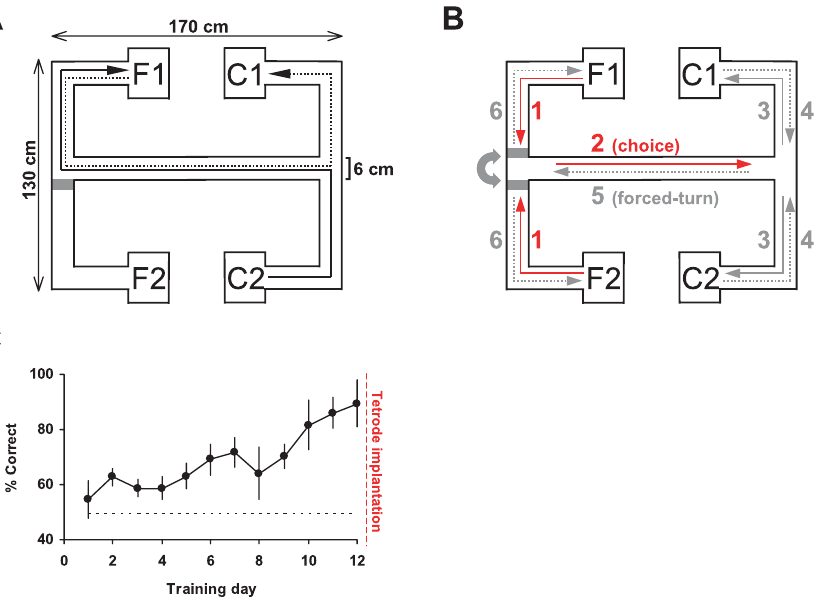
Figure 1. Experimental Design and Performance during the Spatial Working-Memory Task (A) Schematic of the maze and a pair of runs comprising a single trial (forced-turn direction C2 to F1, solid arrow; choice direction F1 to C1, dotted arrow). Grey rectangle marks the moveable barrier. (B) The task was broken down into distinct behavioral stages for analysis: 1, running away from the ‘‘ cue ’’ reward point towards the central arm; 2, crossing the central arm in the choice direction (only activity on the central three-quarters section of the arm was considered for analysis to avoid divergent routes near the turning points and inconsistent running behavior); 3, post-choice running to reward point (rats were rewarded for choosing C1 if the trial started at F1 and for choosing C2 if the trial started at F2); 4, returning to the central arm (where a second barrier blocked the route to the opposite reward point); 5, crossing the central arm in the ‘‘ forced-turn ’’ direction; and 6, returning to one of the two reward points (F1 or F2 chosen at random for each trial). Stages 1 and 2, marked by the red arrows, were presumed to involve working memory and/or decision-making. (C) The six rats were trained to asymptotic working-memory performance for at least 12 d before tetrode implantation. DOI: 10.1371/journal.pbio.0030402.g001 PLoS Biology |